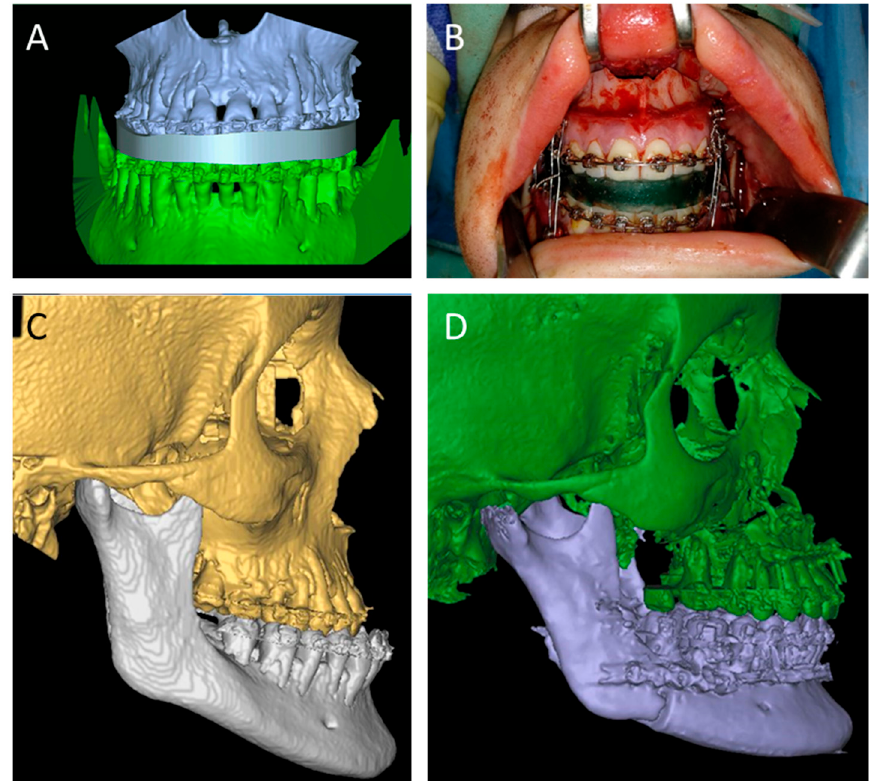
Figure 7. 3D printing for orthognathic surgery. VSP for jaw repositioning with virtually created splint in position ( A ) and printer, Intraoperative use of the 3D printed splint via VAT photopolymerization ( B ) Pre-operative ( C ) and post-operative ( D ) CT-based reconstruction. ( B ) Pre-operative ( C ) and post-operative ( D ) CT-based